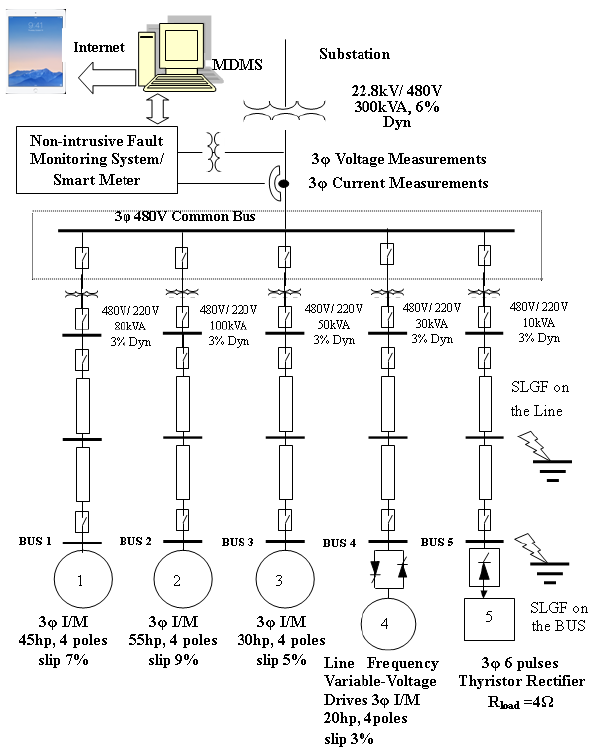
Figure 3. Power fault identification system for a NIFM system. MDMS: meter data management system.